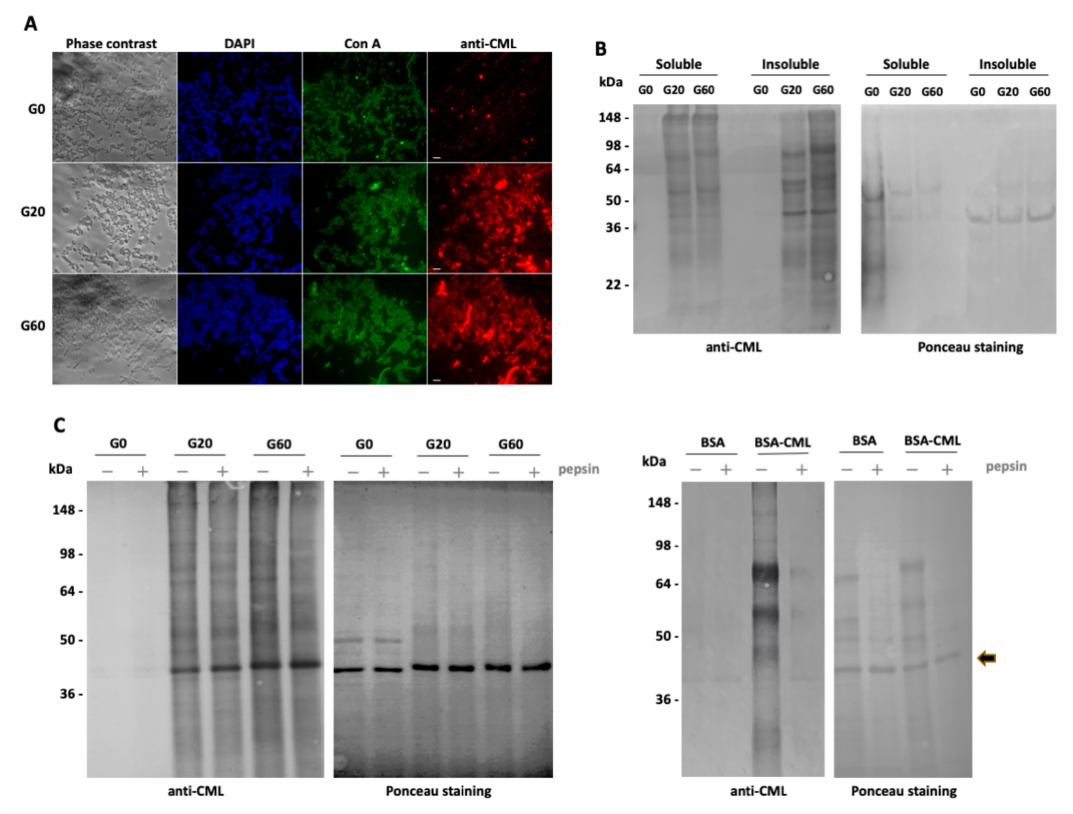
Figure 1. Glycation of bacteria and control of membrane and parietal integrities. ( A ) Indirect immunofluorescence assays were performed on bacteria, which were pretreated with 0 mM (G0), 20 mM (G20) or 60 mM (G60) of glyoxylic acid, using anti- N ε - carboxymethyllysine (CML) antibody and lectin concanavalin A (Con A). Bacteria DNA was stained with DAPI. For each type of bacteria, phase contrast and fluorescence micrographs with the mentioned DNA-binding probe, lectin or antibody are shown. Scale bars = 2 µ m. ( B ) Western blot of soluble and insoluble protein extracts from G0, G20 or G60 bacteria was detected with anti-CML antibody. Before immunostaining, the membrane was stained with ponceau S for loading control. ( C ) Western blots of extracts from G0, G20 or G60 bacteria or non-glycated bovine serum albumin (BSA) or glycated BSA (BSA-CML) were stained with anti-CML antibody. Before electrophoresis, non-glycated and glycated bacteria or BSA were incubated without ( − ) or with (+) pepsin in acidic solution. Before immunostaining, the membranes were stained with ponceau S for loading control. The acidic condition induced the proteolysis of BSA with fragments of different sizes detectable after electrophoretic separation. One of these fragments, marked with an arrow, is known to be resistant to pepsin digestion [53]. All results are representative of 3 independent